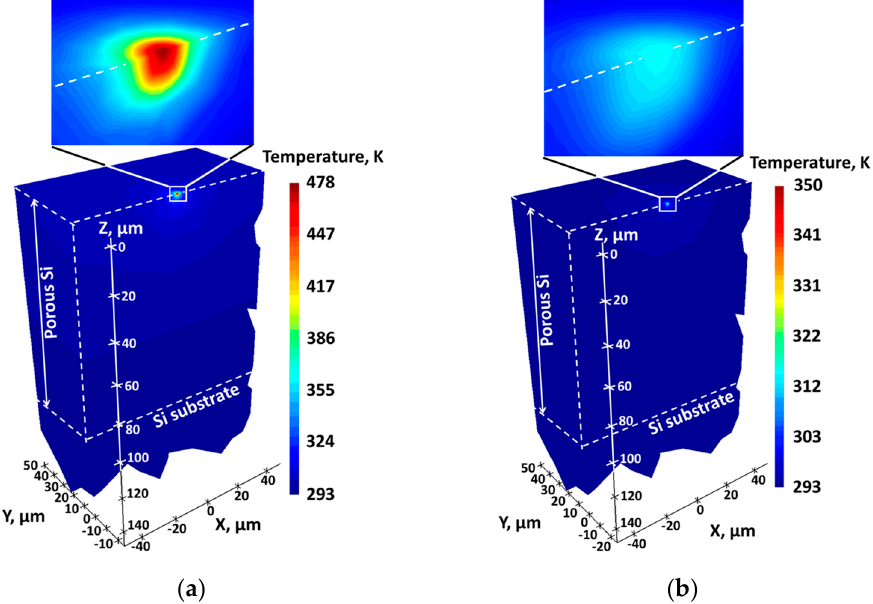
Figure 3. Simulated laser-induced temperature distribution in: ( a ) porous Si layers with empty pores; and ( b ) porous Si/hexadecane composites.